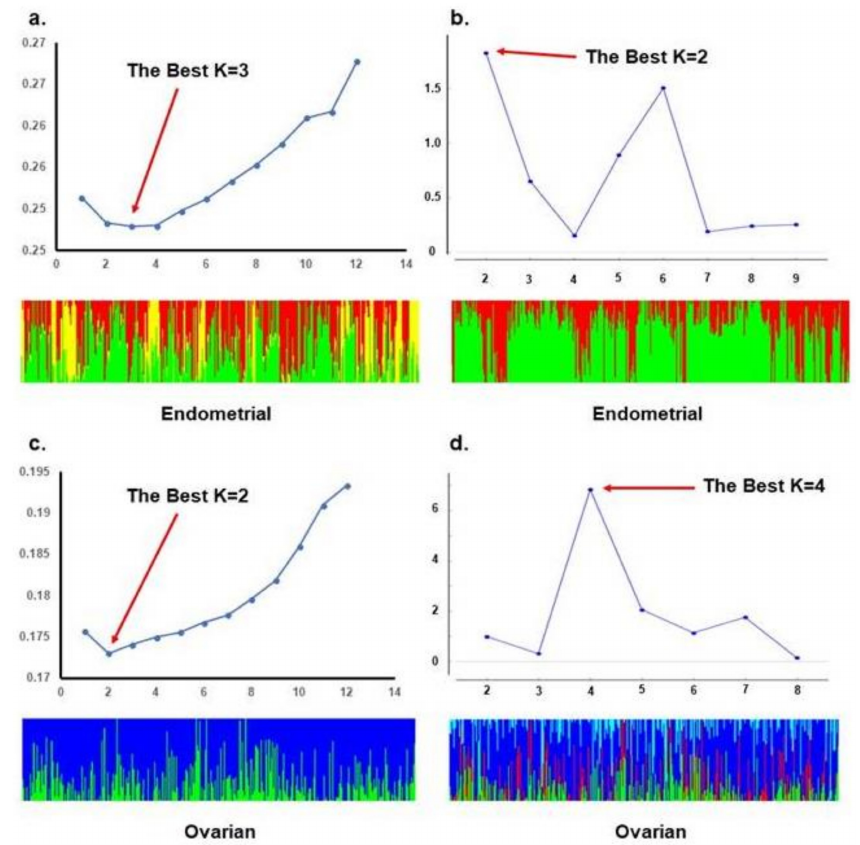
Figure 3. STRUCTURE and ADMIXTURE subpopulations structure analysis of TCGA patients based on the origin of cancer: ( a ). ADMIXTURE analysis and bar plot with an optimal K = 3 subpopulation substructure for endometrial cancer patients of endometrioid type; ( b ). STRUCTURE analysis and bar plot with an optimal K = 2 subpopulation substructure for endometrial cancer patients of endometrioid type; ( c ). ADMIXTURE analysis and bar plot with an optimal K = 2 subpopulation substructure for serous ovarian cancer patients; ( d ). STRUCTURE analysis and bar plot with an optimal K = 4 subpopulation substructure for serous ovarian cancer